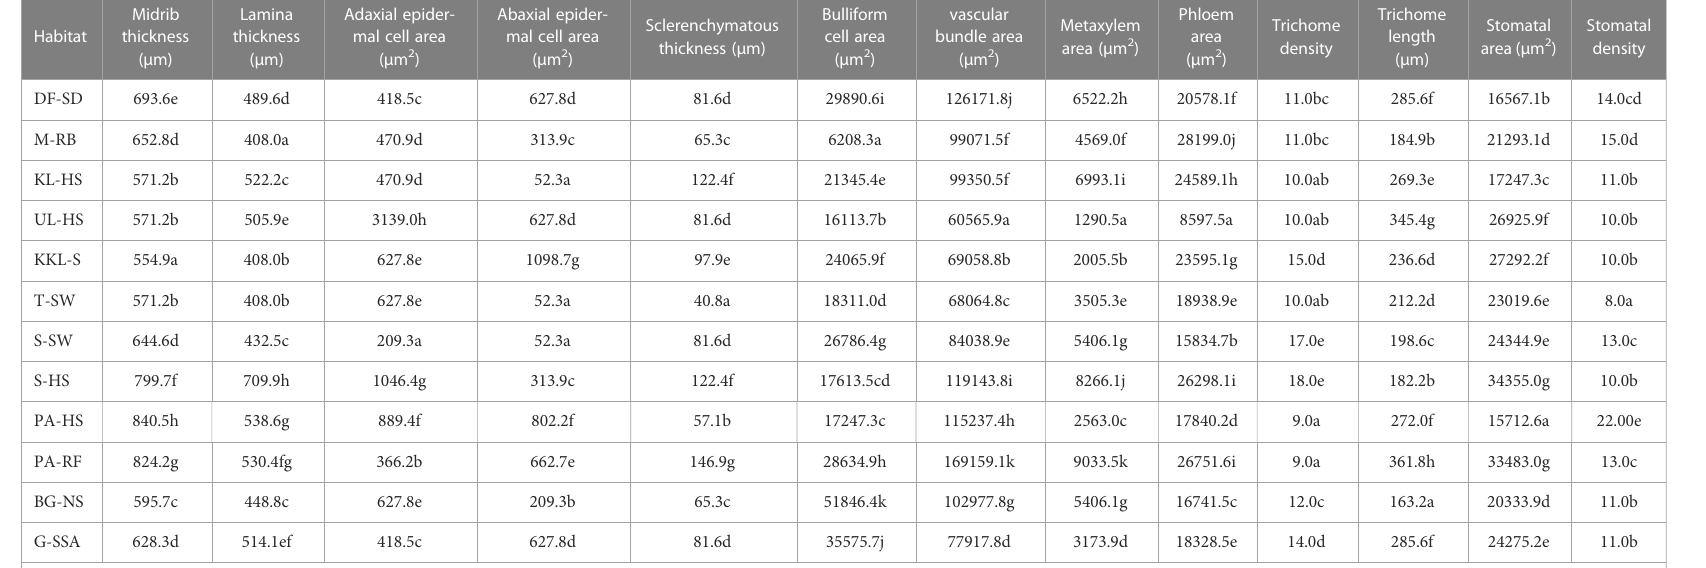
TABLE 4 Leaf anatomical characteristics of the selected habitats from Punjab,